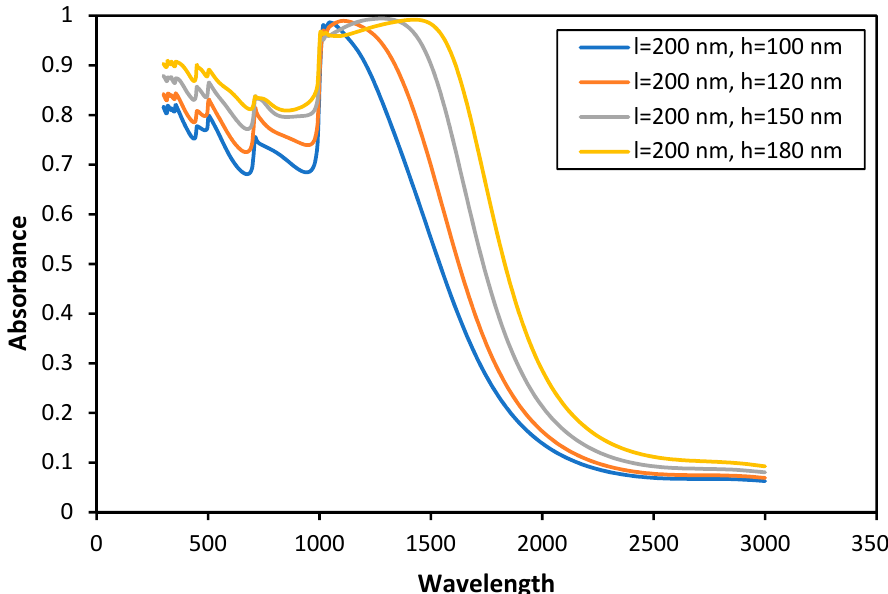
Figure 6. The RMS height effect on the bandwidth of absorbance.